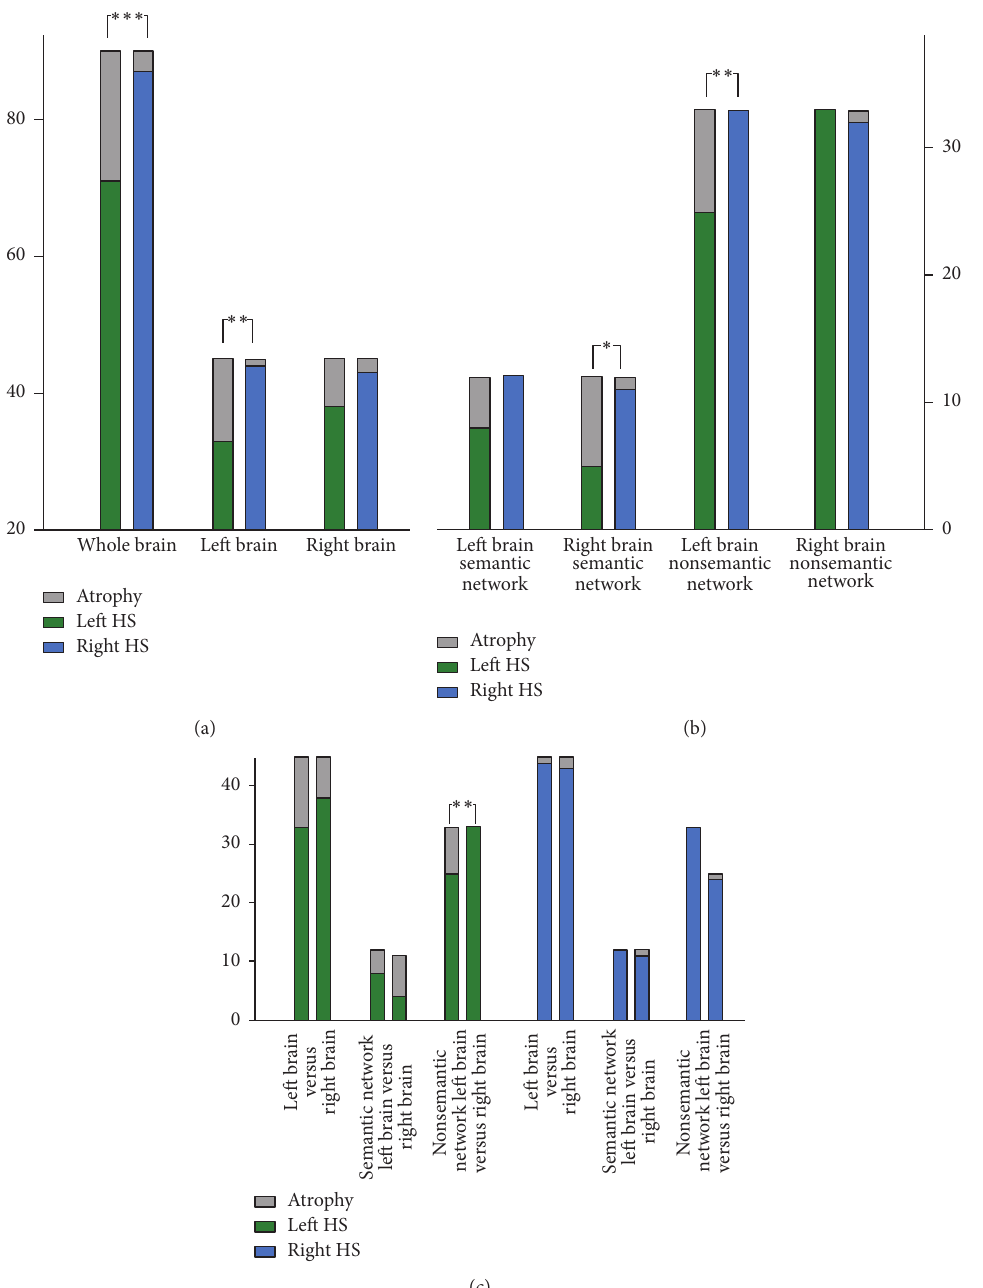
Figure 2: Comparison of atrophy severity of the left and right HS patients in both hemispheres. (i) The whole brain and especially the left hemisphere were more severely damaged in left HS patients than right HS patients. (ii) The atrophy severity of the semantic cognition network in the right hemisphere was more severe for left HS patients than right HS patients. (iii) “ ∗ ” indicates 𝑝 < 0.05 ; “ ∗∗ ” indicates 𝑝 < 0.01 ; “ ∗ ∗ ∗ ” indicates 𝑝 <